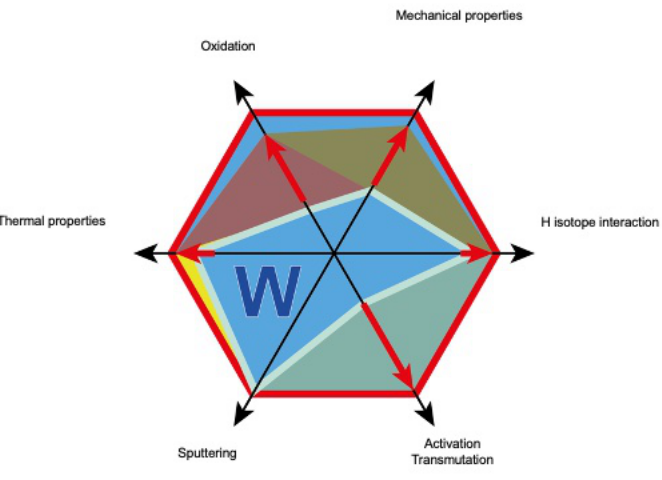
Figure 1. W, the first wall and divertor material, still faces challenges. The red lines give the performance with respect to ideal behaviour, represented by the outline of the hexagon. The core blue area is the status quo